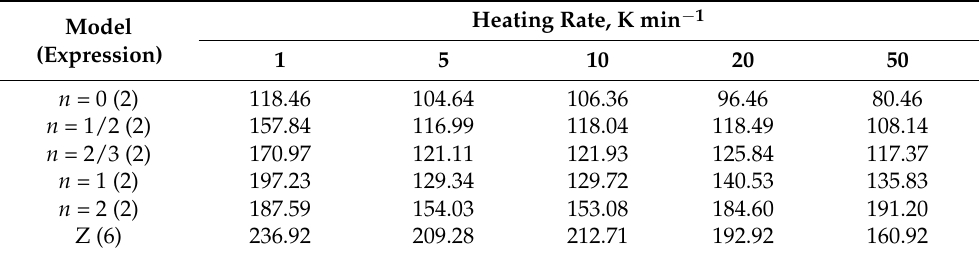
Table 2. Activation energy values of reaction C + CO 2 (kJ mol − 1 ) based on the results of TG curves